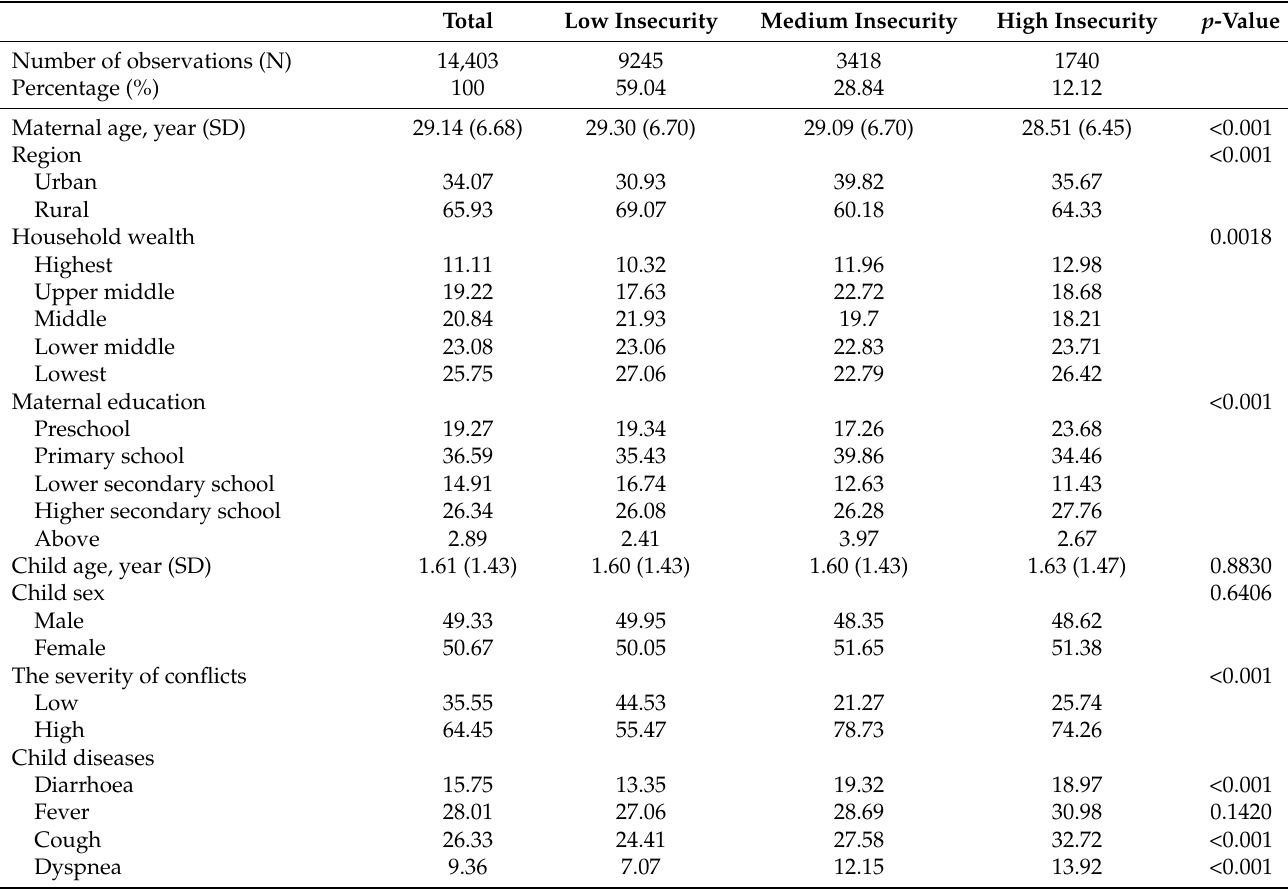
Table 3. Characteristics of children under five †.